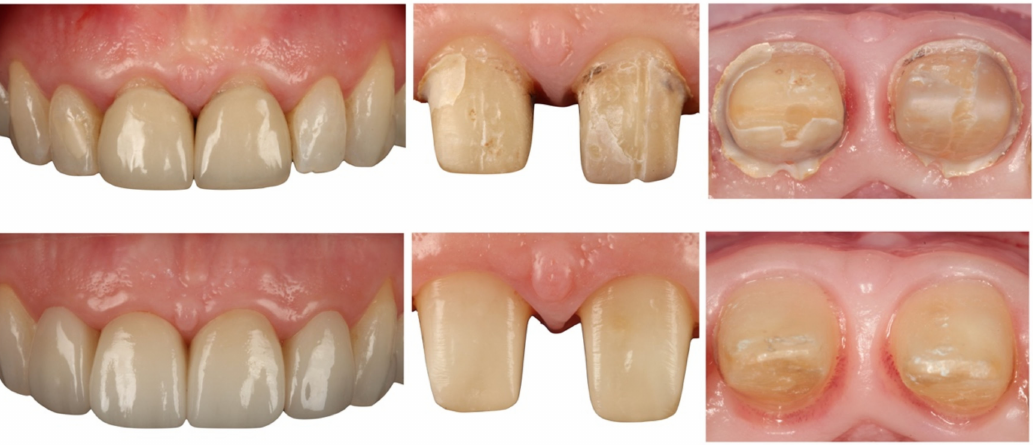
Figure 14. Gingival tissue stability with BOPT